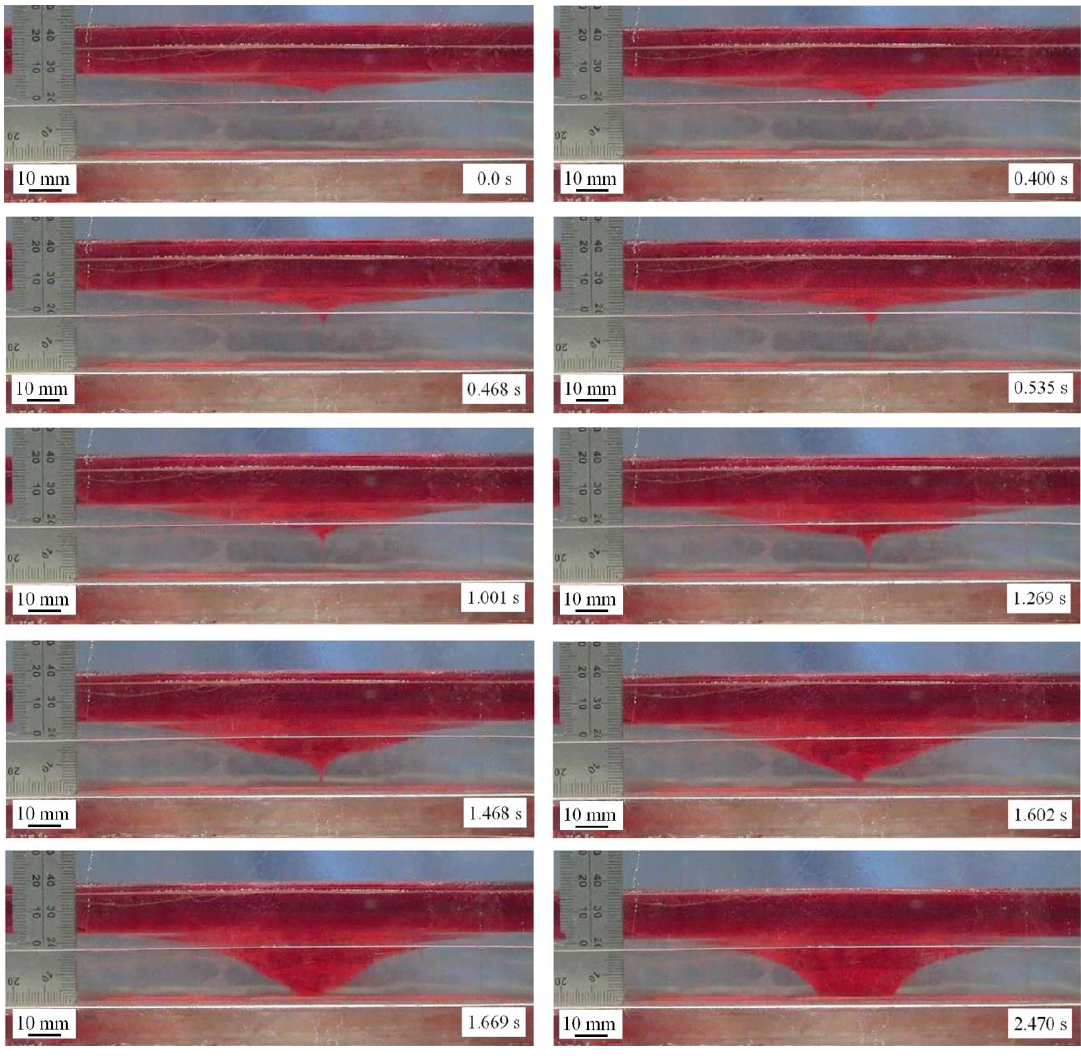
Figure 4. Behavior of slag carry-overcaused by vortex and drain sink from a physical model.